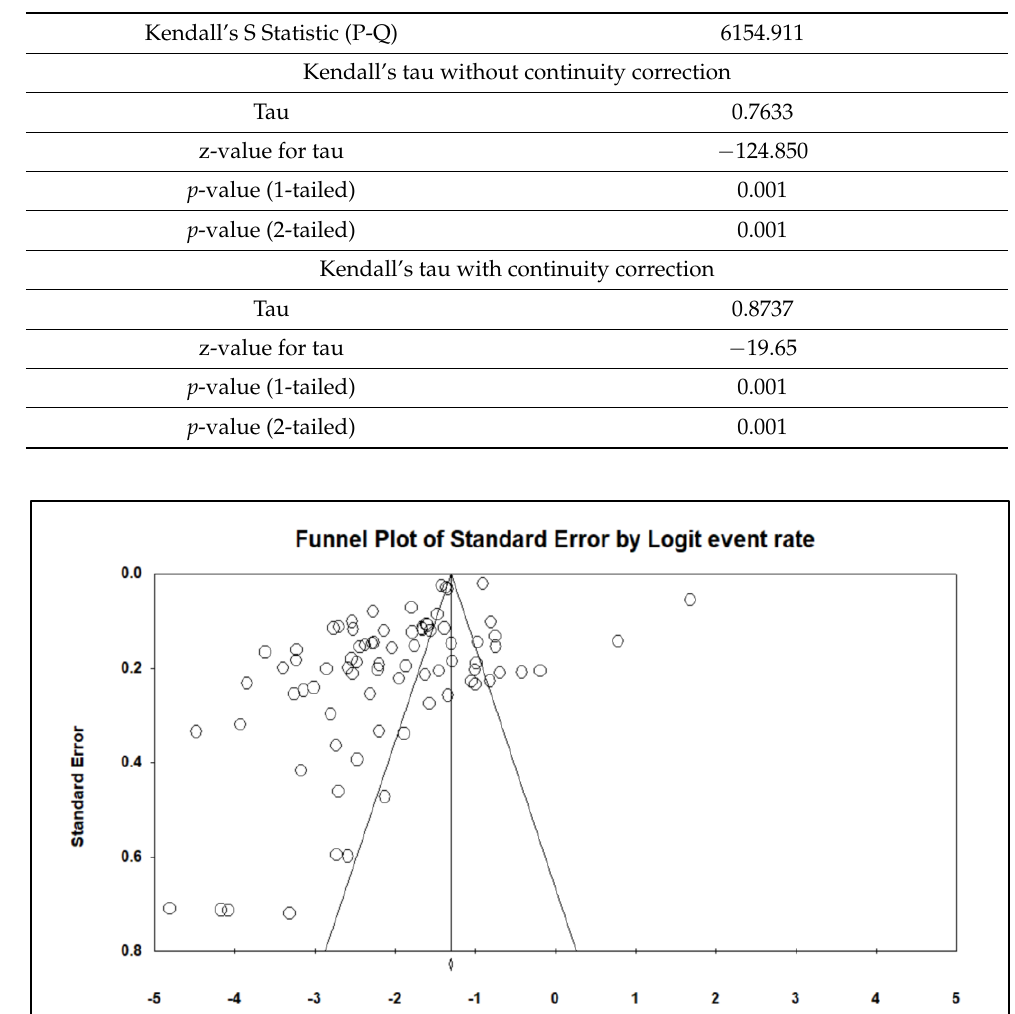
Table 3. Begg’s and Mazumdar’s rank correlation.